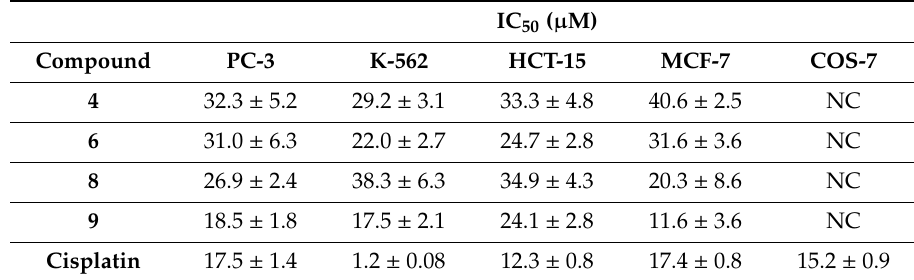
Table 2. The e ff ect of olsalazine-PAMAM-dendrimers 4 and 6 and olsalazine-PAMAM-dendrimer- salicylic acid-conjugates 8 and 9 on the viability of di ff erent tumor cell lines and the COS-7 cell line expressed as IC 50 in µ